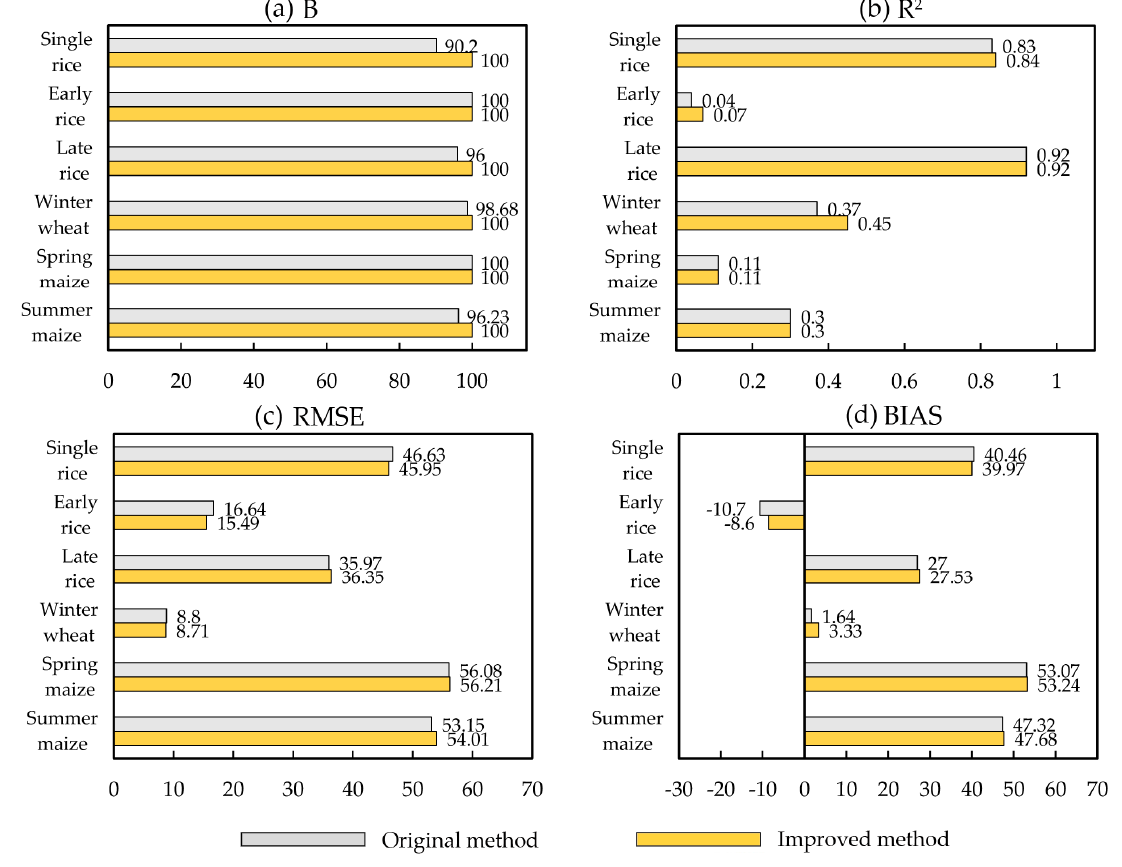
Figure 4. Comparison of the end of the season (EOS) retrieval results before (gray bars) and after algorithm improvement (orange bars), and both are based on the 20% amplitude threshold ( a ) B, ( b ) Coefficient of determination (R 2 ), ( c ) Root Mean Square Error (RMSE), ( d ) BIAS.